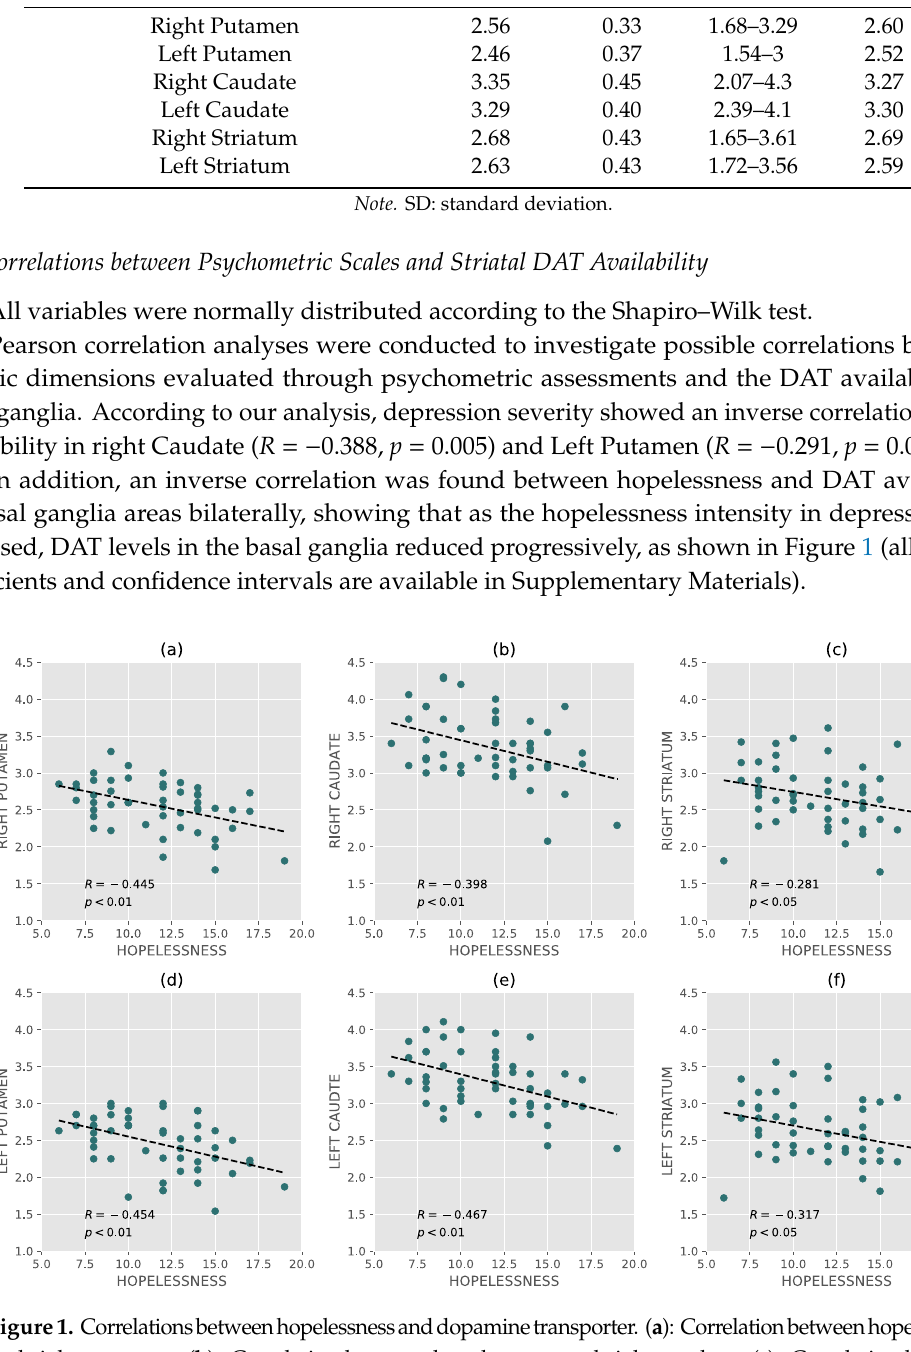
Table 2. DAT striatal availability.